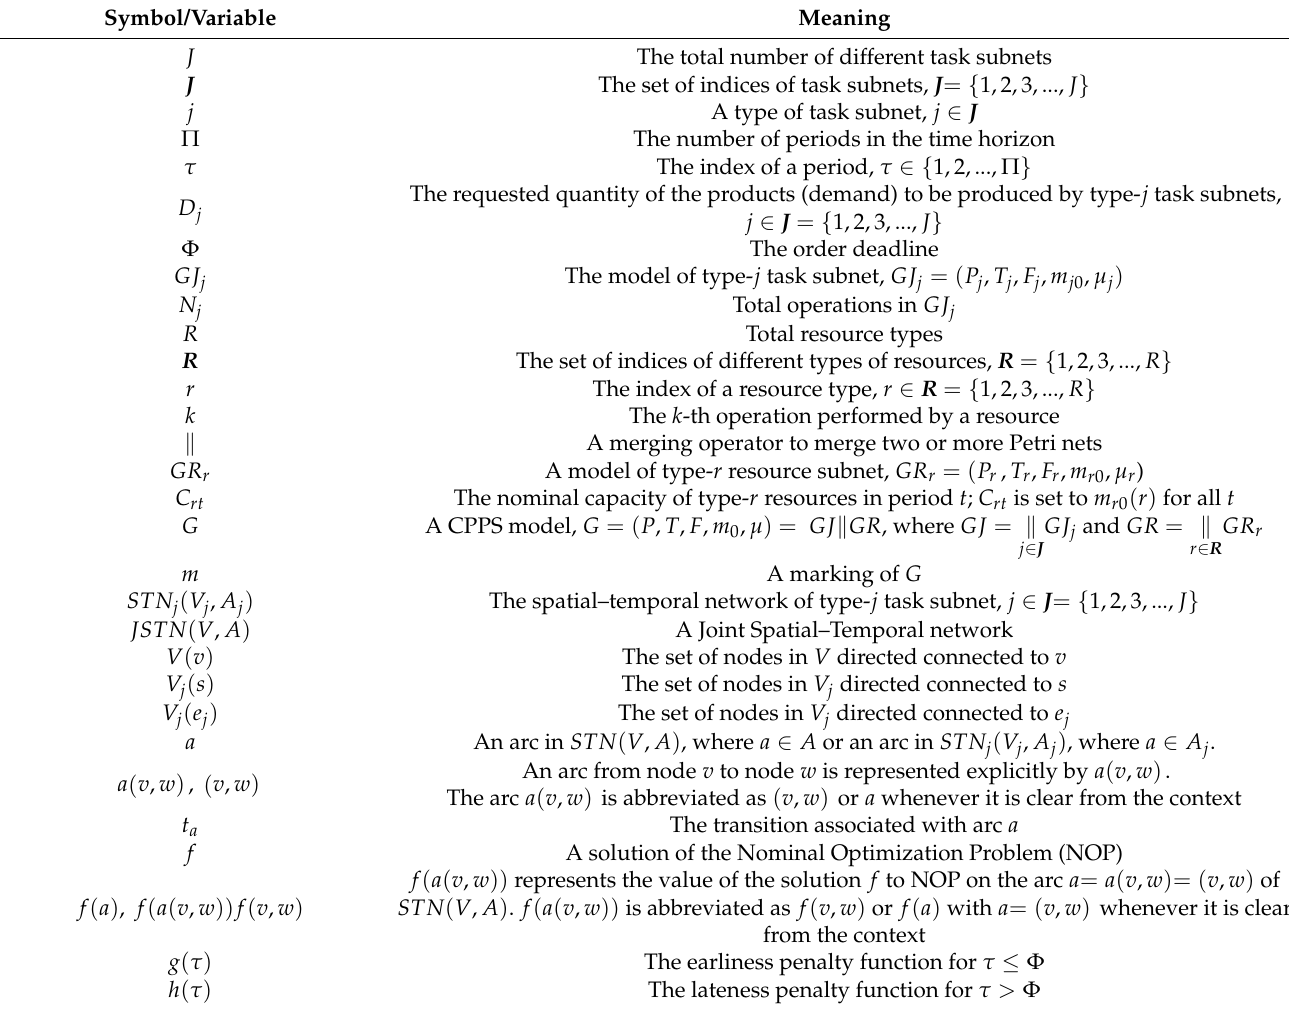
Table 1. Symbols and